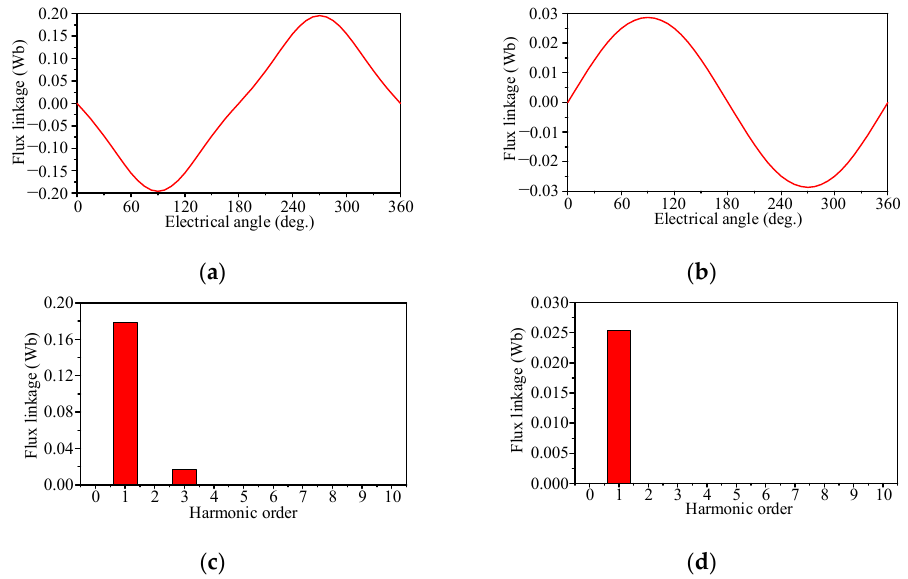
Figure 10. PM flux linkage: ( a ) 8-pole mode; ( b ) 24-pole mode. Spectrum of: ( c ) 8-pole mode; ( d ) 24-pole mode.